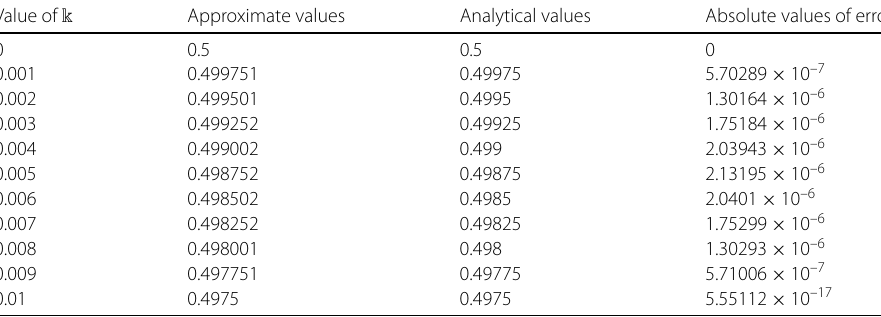
Table 2 Analytical, numerical, and absolute values in different values of k via quantic B-spline scheme, showing the accuracy of the obtained analytical solution Value of k Approximate values Analytical values Absolute values of error 0 0.5 0.5 0